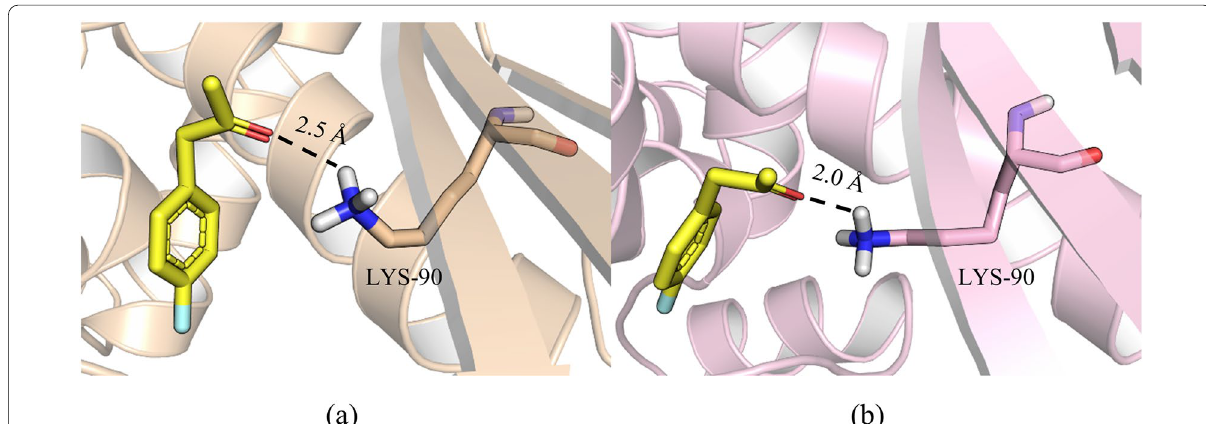
Fig. 3 Molecular docking of pFPA with F- Bb AmDH ( a ) and cFLF-AmDH ( b ). Substrate pFPA is shown as yellow sticks. Key residue K90 is shown as cyan sticks